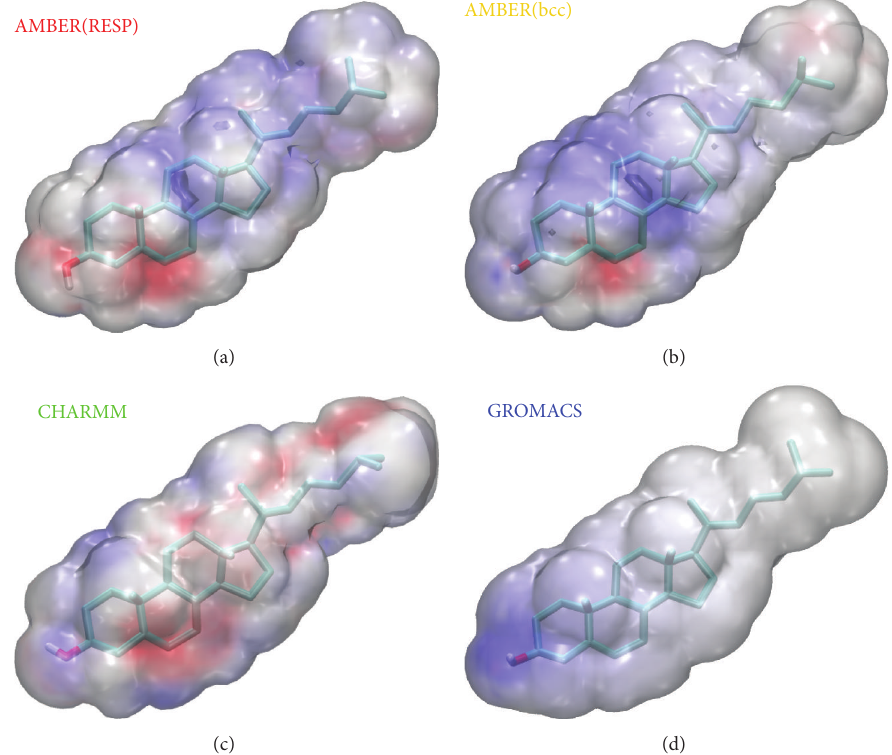
Figure 3: Membrane specific electrostatic potentials [15, 41] (ESPs) on the molecular surface of cholesterol. The assignment of partial charges is based on force fields: (a) AMBER(RESP), (b) AMBER(bcc), (c) CHARMM, and (d) GROMACS. Shown are color-coded ESPs (dark red: 𝑇/𝑞 − 5 𝑘 ; dark blue: +5 𝑘 𝐵 𝑇/𝑞 ) mapped onto the molecular surface of the average structure revealed from 5 ns of MD simulation. Standard 𝐵 el el or slightly increased van der Waals radii form the basis of molecular surface calculation.